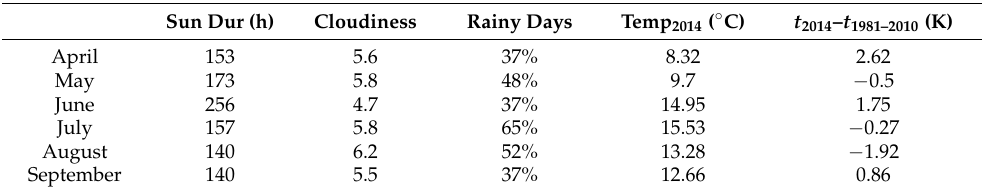
Table 2. Monthly weather characteristics of the nearby DWD weather station “Klippeneck” in 2014. The deviation from the long-term average is given in Kelvin